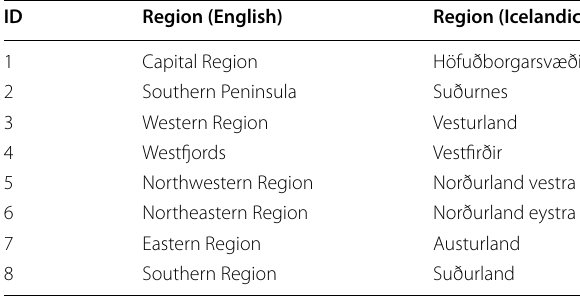
Only the IDs in the first column are stored in the master